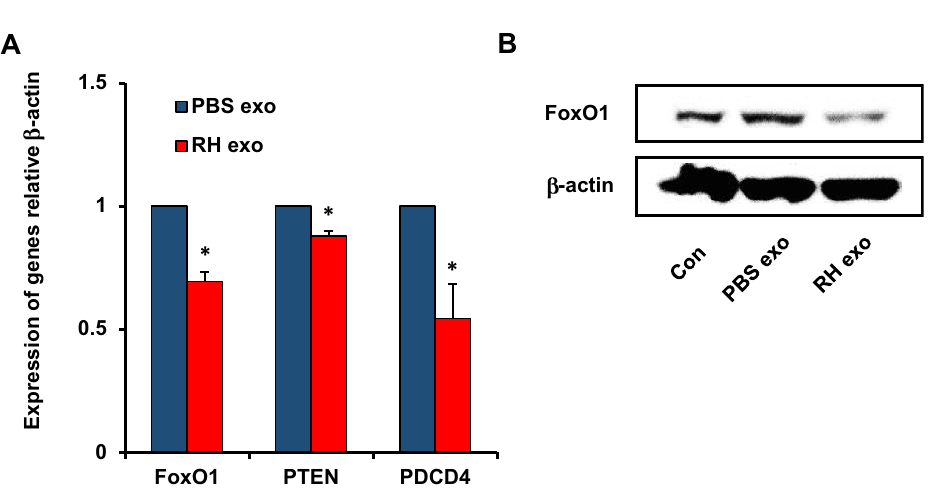
Figure 5. Toxoplasma RH-infected BV2-derived exosomes induce downregulation of anti-tumor associated genes in U87 glioma cells by Toxoplasma RH-infected BV2-derived exosomes. ( A ) Real-time PCR for FoxO1, PTEN, and PDCD4 expressions in Toxoplasma RH-infected BV2-derived exosomes versus those with PBS exosomes. β-actin mRNA was used as a control. ( B ) FoxO1 expression was determined by Western blot analysis and the statistical evaluation of densitometry data was performed using the ImageJ program. * P < 0.05 was obtained by Student’s t